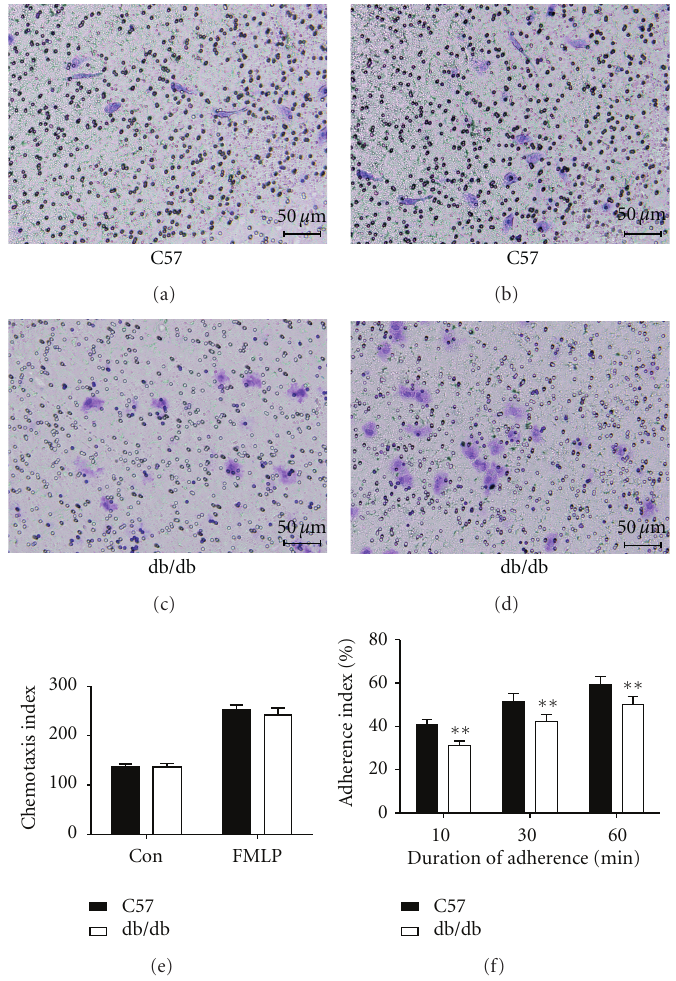
Figure 3: Impaired chemotaxis and adhesion capacity of RPMs from 5-month db/db mice. FMLP induced migration of RPMs from normal mice (b) and db/db mice (d) was stained by Crystal Violet; while (a) and (c) were RPMs from normal and db/db mice, respectively, with no chemokine by crystal violet staining. The average CI (e) and AI (f) of RPMs of four independent experiments was quantified. Scale bars represent 50 μ m. ∗∗ P < 0.01 versus the control